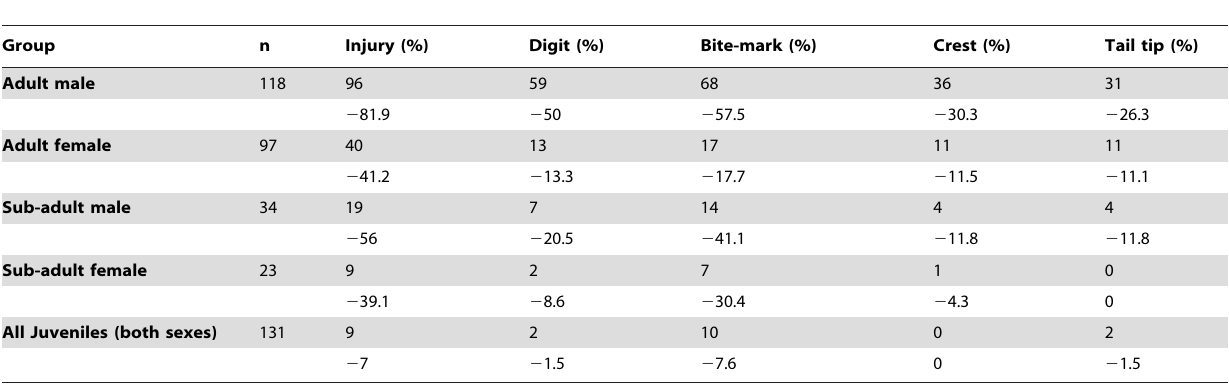
Table 3. Injury rates by sex and size class for B.